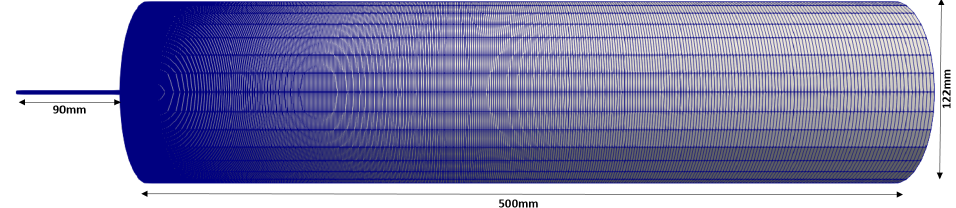
Figure 9. Dimensions of the computational domain of mesh 1 consisting of the injector and half-length chamber.